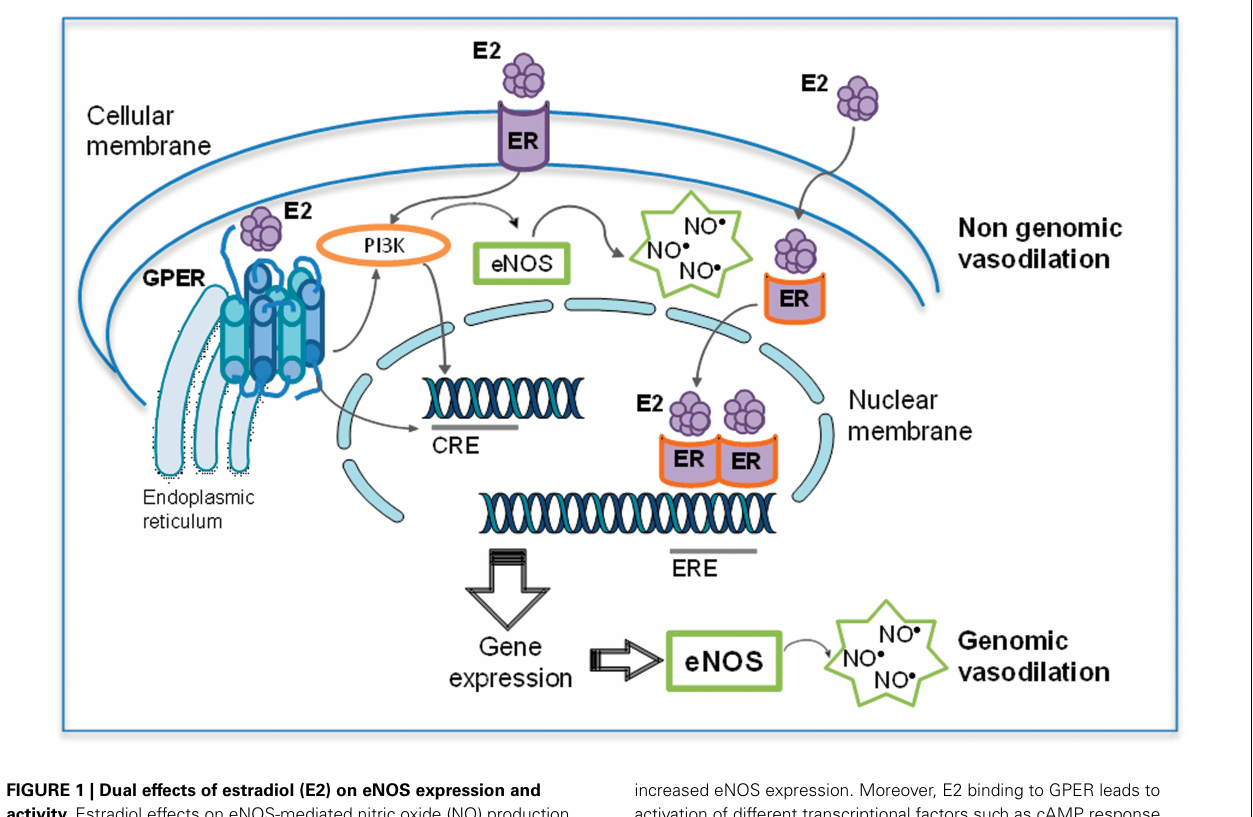
FIGURE 1 | Dual effects of estradiol (E2) on eNOS expression and activity. Estradiol effects on eNOS-mediated nitric oxide (NO) production include both genomic and non-genomic effects. Genomic effects include the classical intracellular estrogen receptors (ER), which after binding of E2 interact with estrogen-response element (ERE) in DNA, resulting in an